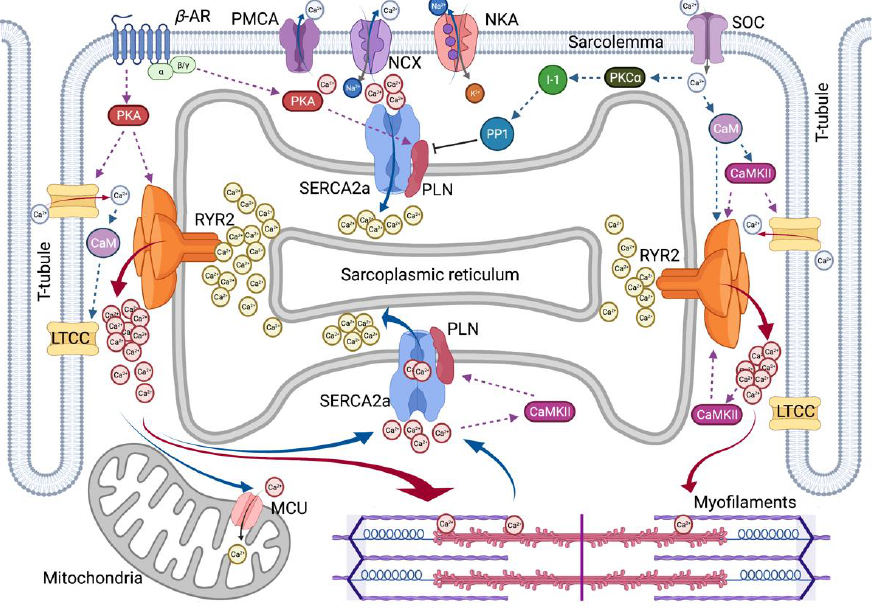
Figure 1. Overview of Intracellular Ca 2+ Cycling in Cardiomyocytes. Schematic overview summarizes excitation–contraction coupling in cardiomyocytes. βAR, β–adrenergic receptor; CaM, calmodulin; CaMKII, Ca 2+ /CaM-dependent kinase II; I-1, Inhibitor-1; LTCC, L-type Ca 2+ channel; MCU, Mitochondrial Ca 2+ uniporter; NCX, Na + /Ca 2+ exchanger; NKA, Na⁺/K⁺-ATPase; PKA, Protein kinase A; PKCα, Protein kinase C α-isoform; PLN, Phospholamban; PMCA, Plasma membrane Ca 2+ –ATPase; PP1, Protein phosphatase-1; RYR2, Ryanodine receptor type-2; SERCA2a, Sarco/endoplasmic reticulum Ca 2+ -adenosine triphosphatase 2; and SOC, store-operated channel. Red solid arrow represents Ca 2+ -induced Ca 2+ release. Blue solid arrow represents Ca 2+ extrusion in diastolic relaxation. Dotted lines represent a positive or negative effect on the following molecules.